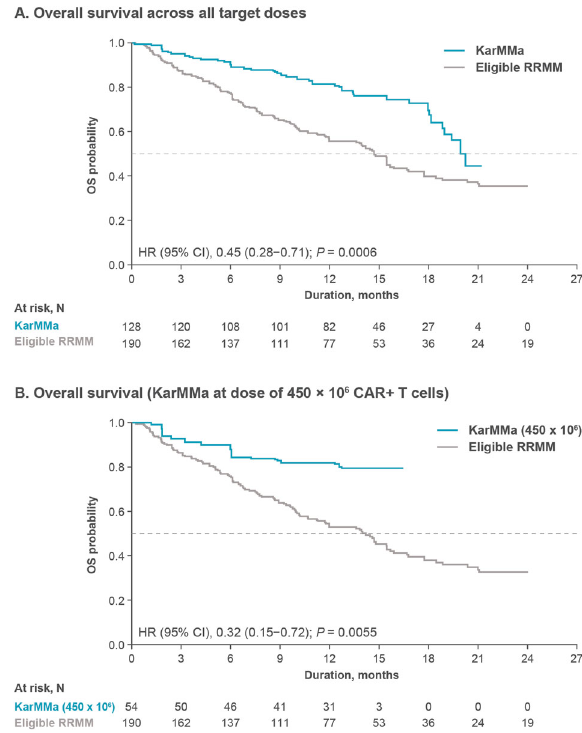
Fig. 3 Overall survival. A shows a Kaplan – Meier curve of overall survival across all target doses and B shows a Kaplan – Meier curve of overall survival at the target dose of 450 × 10 6 CAR + T cells based on Independent Response Committee Review according to IMWG criteria applying Food and Drug Administration censoring rules. IMWG denotes International Myeloma Working Group, NE not